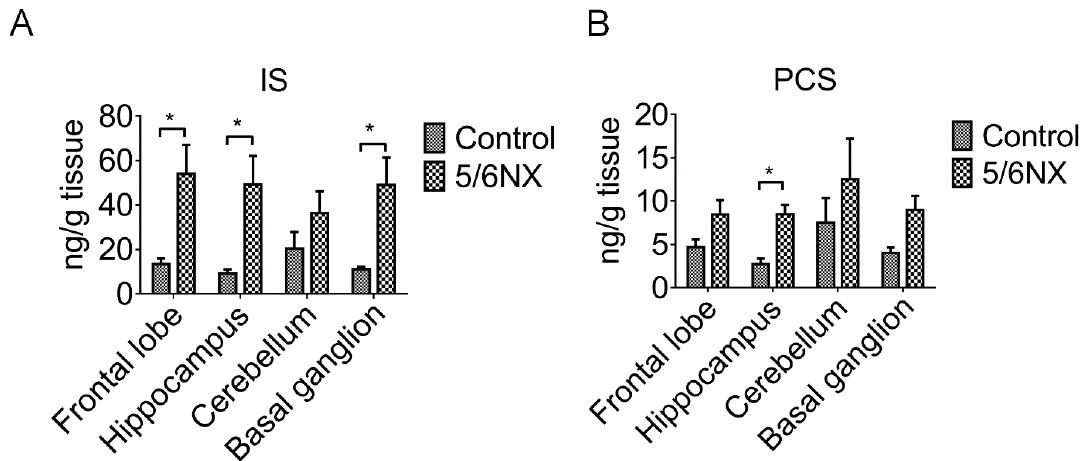
Figure 3. Indoxyl sulfate (IS) and p-cresol sulfate (PCS) levels were elevated in various brain regions of 5/6 nephrectomy (5/6 NX) animals compared with the levels in sham animals. Brain tissues were extracted using methanol and analyzed through high-performance liquid chromatography. There were significantly increased IS levels in the frontal lobe, hippocampus, and basal ganglia of 5/6 NX animals; however, the increase in IS levels in the cerebellum was significant (panel ( A )). Moreover, PCS levels were increased in the various brain regions and showed a significant increase in the hippocampus compared with those in sham-control animals (panel ( B )). These findings suggested that uremic toxins could penetrate the blood–brain barrier and accumulate in the brain of 5/6 nephrectomy animals. (* p ≤ 0.1; n = 4).